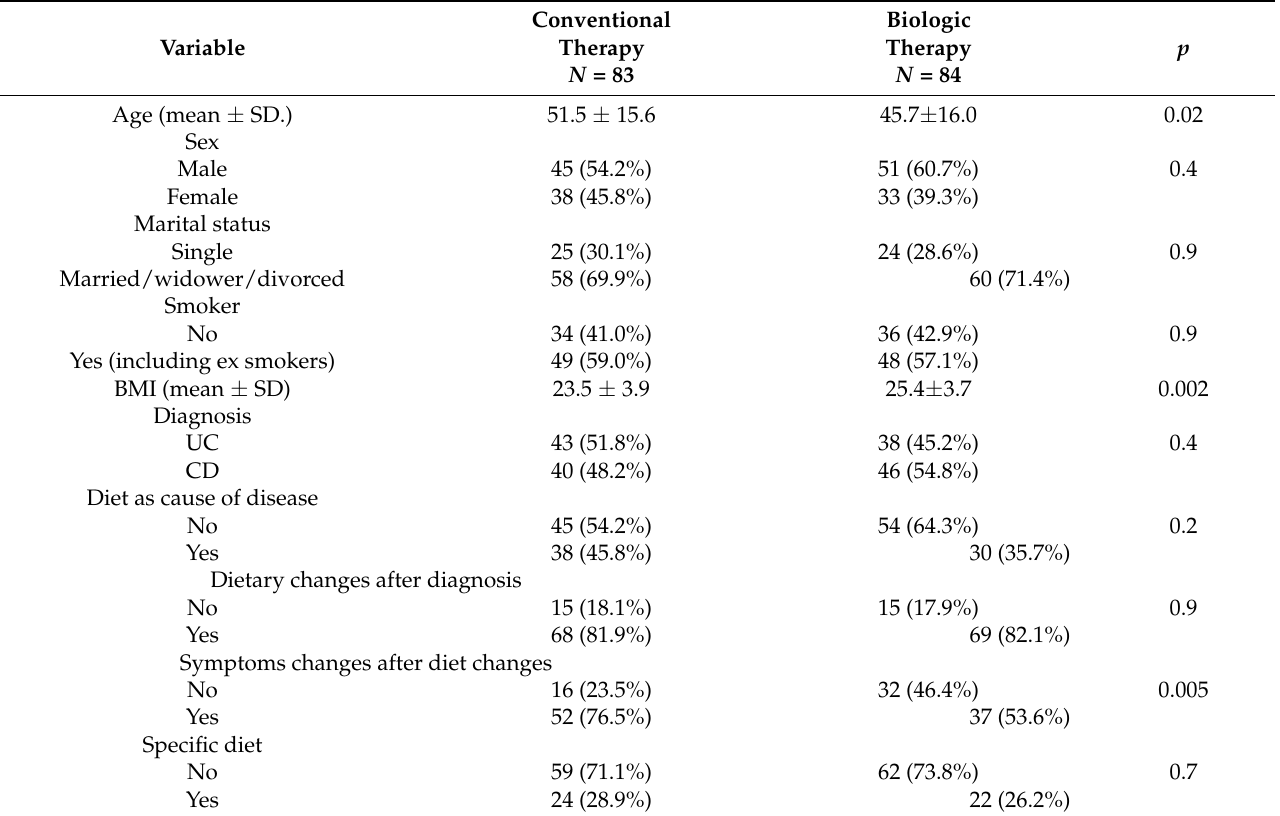
Table 2. Comparison between the two groups of patients: patients treated with conventional therapy and patients treated with biologics.